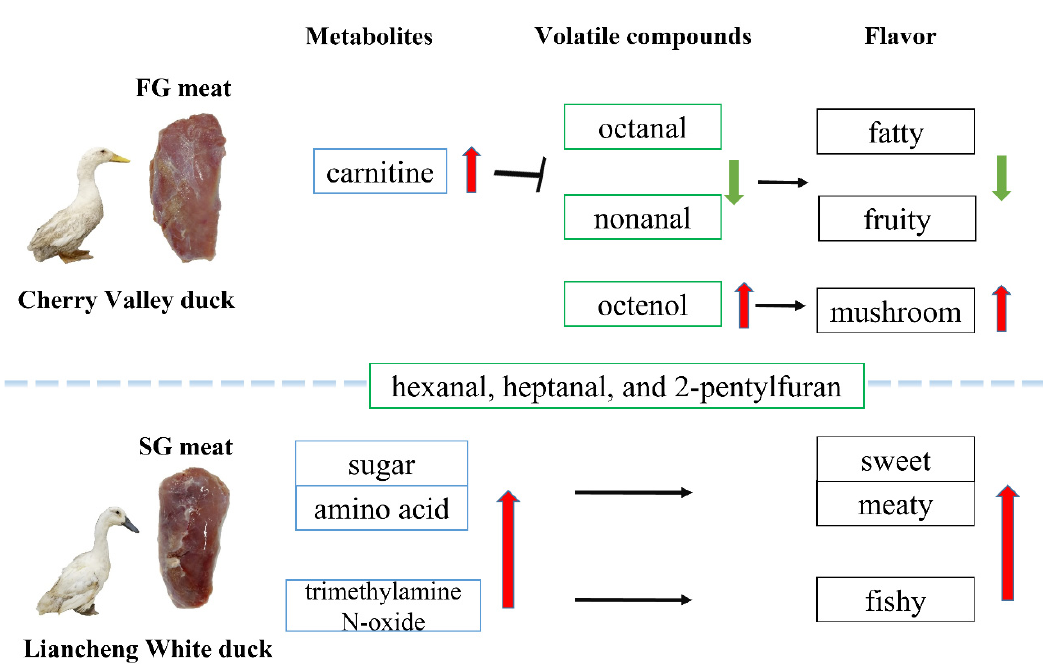
Figure 5. Schematic illustrating key volatile aroma compounds in SG and FG raw duck meat. Hexanal, heptanal, and 2-pentylfuran were the common volatile compounds in duck meat. Higher carnitine was present in FG meat, which reduce lipid deposition to produce more octanal and nonanal. SG meat may be fatty and fruity for higher rate of nonanal and octanal. FG meat has a more mushroom note for higher rate of octenol. Higher sugar and amino acid contents led to sweet and meaty aroma, while higher trimethylamine N-oxide content may generate fishy note in SG meat.